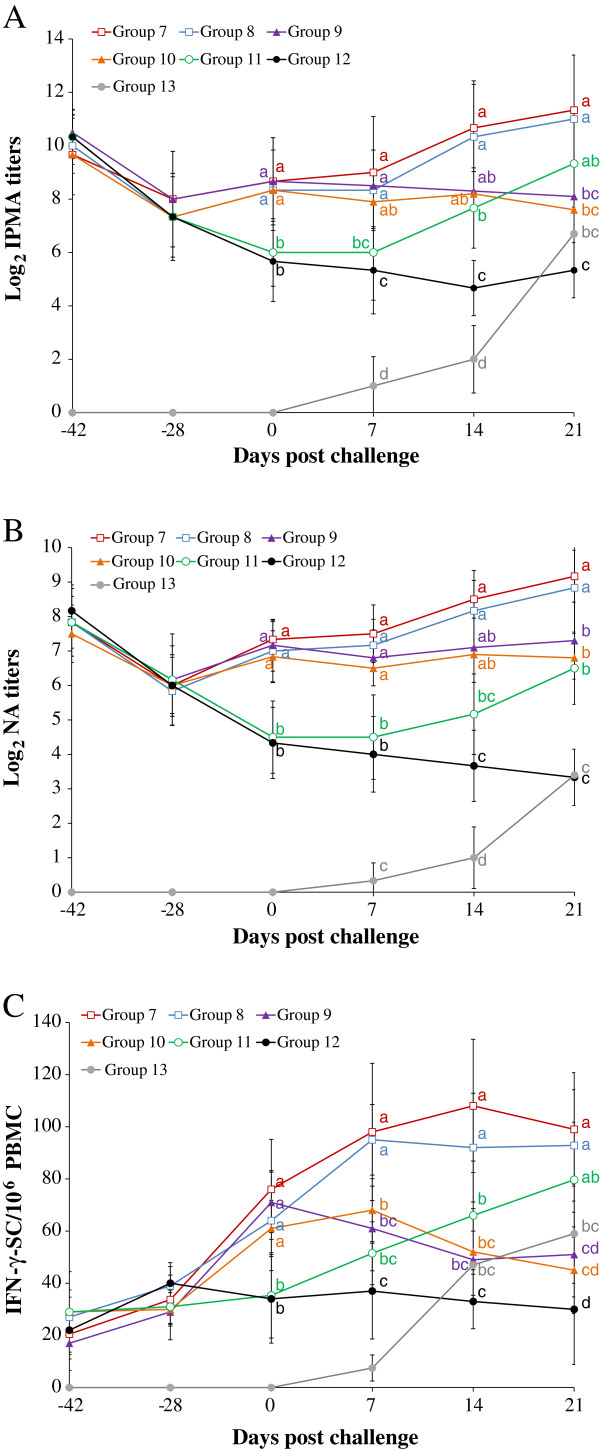
PCV2a-specific humoral and cell-mediated immune responses. Log2 transformed group means for PCV2a-specific immunoperoxidase monolayer assay (IPMA) titers (A), neutralizing antibody (NA) titers (B), and frequency of PCV2a-specific interferon-γ-secreting cells (IFN- γ-SC)/106 peripheral blood mononuclear cells (PBMC) (C) from 7 different groups (commercial inactivated chimeric PCV1-2 vaccinated PCV2a-challenged PCV2b-viremic pigs (group 7), experimental inactivated PCV2 vaccinated PCV2a-challenged PCV2b-viremic pigs (group 8), commercial inactivated chimeric PCV1-2 vaccinated unchallenged PCV2b-viremic pigs (group 9), experimental inactivated PCV2 vaccinated unchallenged PCV2b-viremic pigs (group 10), unvaccinated PCV2a-challenged PCV2b-viremic pigs (group 11), unvaccinated unchallenged PCV2b-viremic pigs (group 12), and unvaccinated PCV2a-challenged non-PCV2-viremic pigs (group 13)). Different letters (a, b, c, and d) indicate statistically significant differences (P < 0.05) among groups.